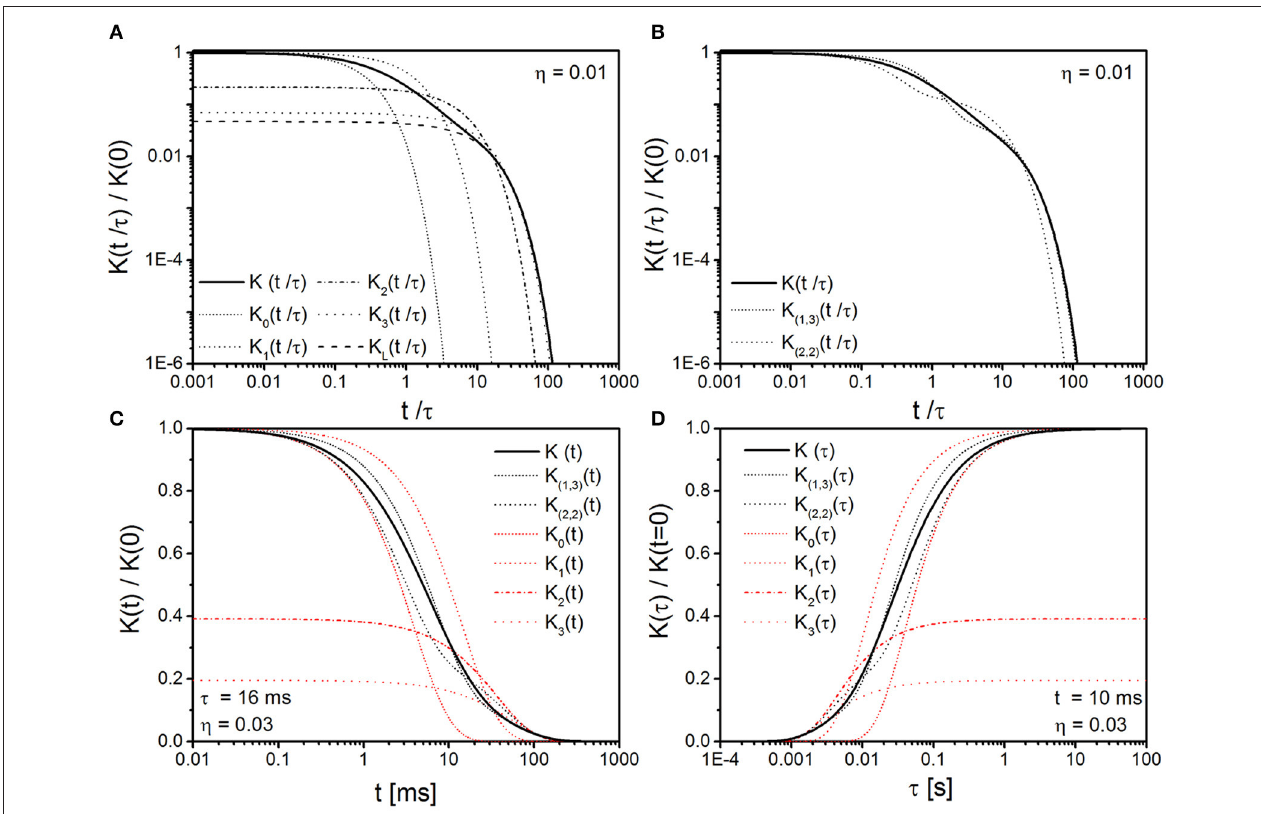
FIGURE 5 | Mono- and bi-exponential approximation in the GMA of cylindrical objects. (A) Monoexponential approximations K i ( t ) of the correlation function K ( t ) (solid line) as obtained from Equation (B3) with moments given in Schulten et al. [46]. The long time approximation K L ( t ) (dashed line) is given by Equation (20) where the first eigenvalue κ 1 is determined by Equation (19) ( η 0.01 in A,B ). (B) Biexponential approximations for long times K (1,3) ( t ) [dashed line obtained from = Equation (39)] and for short times K (2,2) ( t ) [dotted line obtained from Equation (37)] of the correlation function K ( t ) [solid line obtained from Equation (14)]. As in the case for spherical objects, the biexponential approximations of the correlation function for cylindrical objects show a better asymptotic agreement with the actual correlation function K ( t ) than monoexponential approximations. (C) Mono- and bi-exponential approximations of the correlation function for typical parameters of capillaries in brain tissue, see main text for details. The deviations of the biexponential approximations from K ( t ) are visibly smaller than that of the monoexponential approximations. (D) Mono- and bi-exponential approximations of the correlation function in dependence on correlation time τ at time-point t 10ms, for otherwise = equal parameters as in (C) . The approximations K 0 ( τ ), K 1 ( τ ), K (1,3) ( τ ), and K (2,2) ( τ ) coincide with K ( t ) for very short and very long correlation times, whereas correlation function K ( τ ) for intermediate correlation times between 1ms and 1s is best approximated by the biexponential approximations.